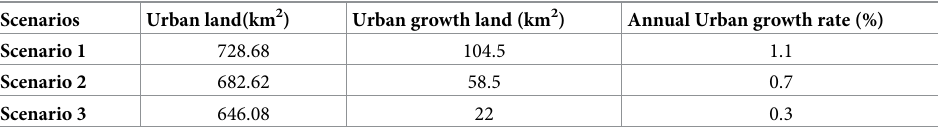
Table 3. Predicted urban expansion statistics, in 2030, under three scenarios.